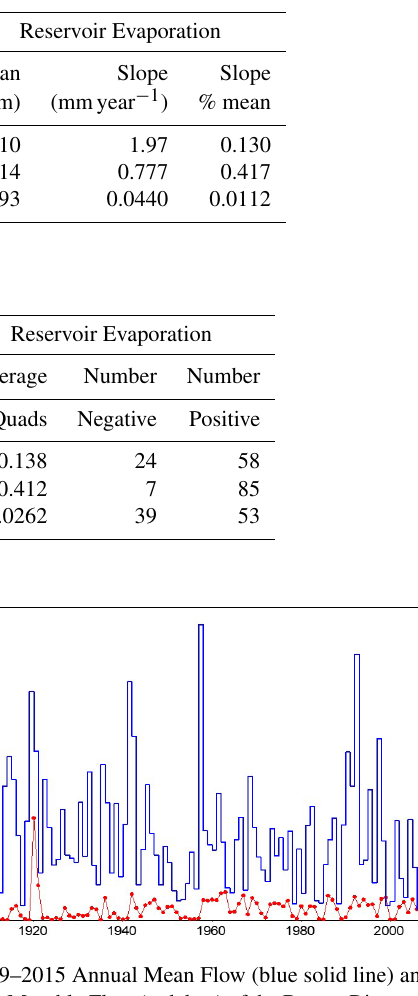
Table 1. Statistics for mean statewide precipitation and evaporation.